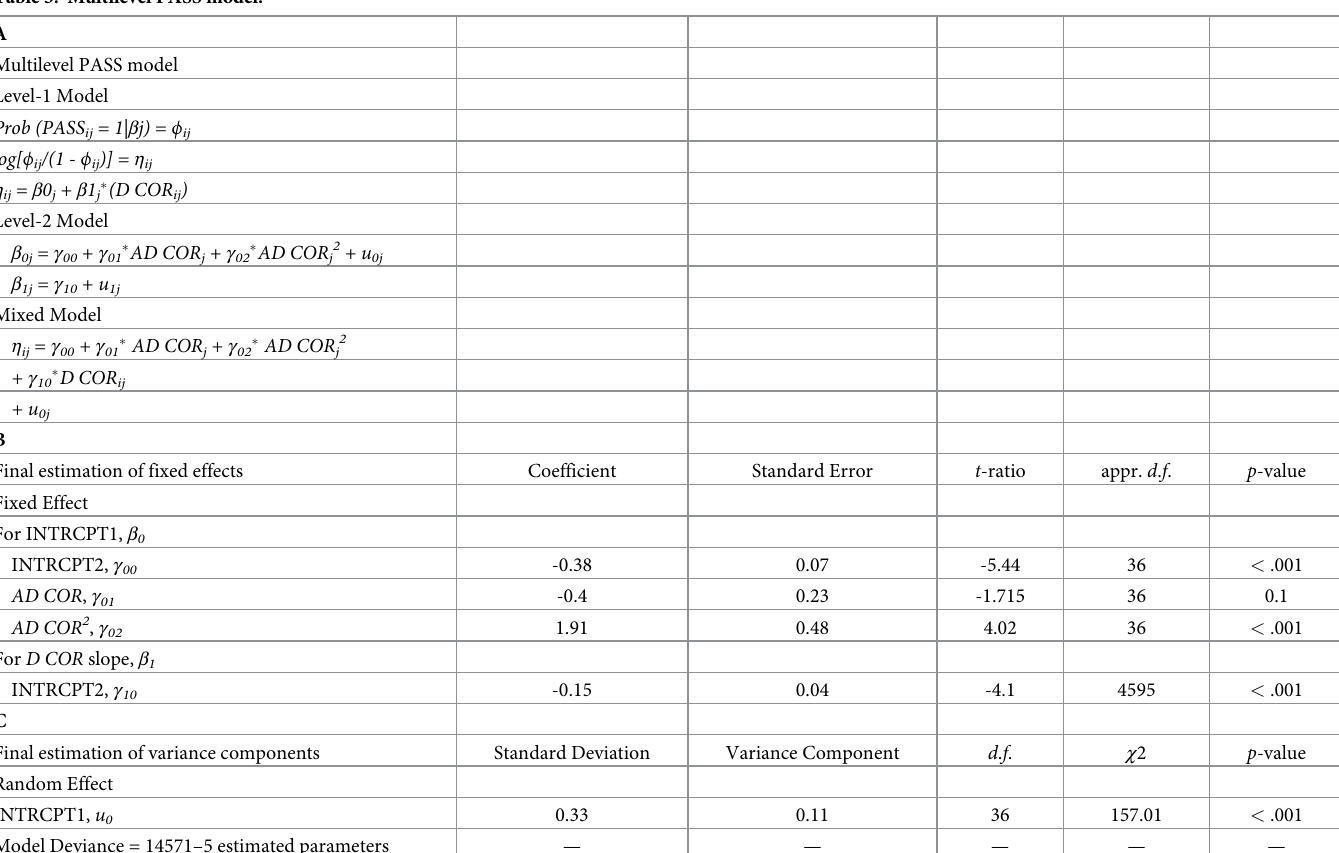
Table 5. Multilevel PASS